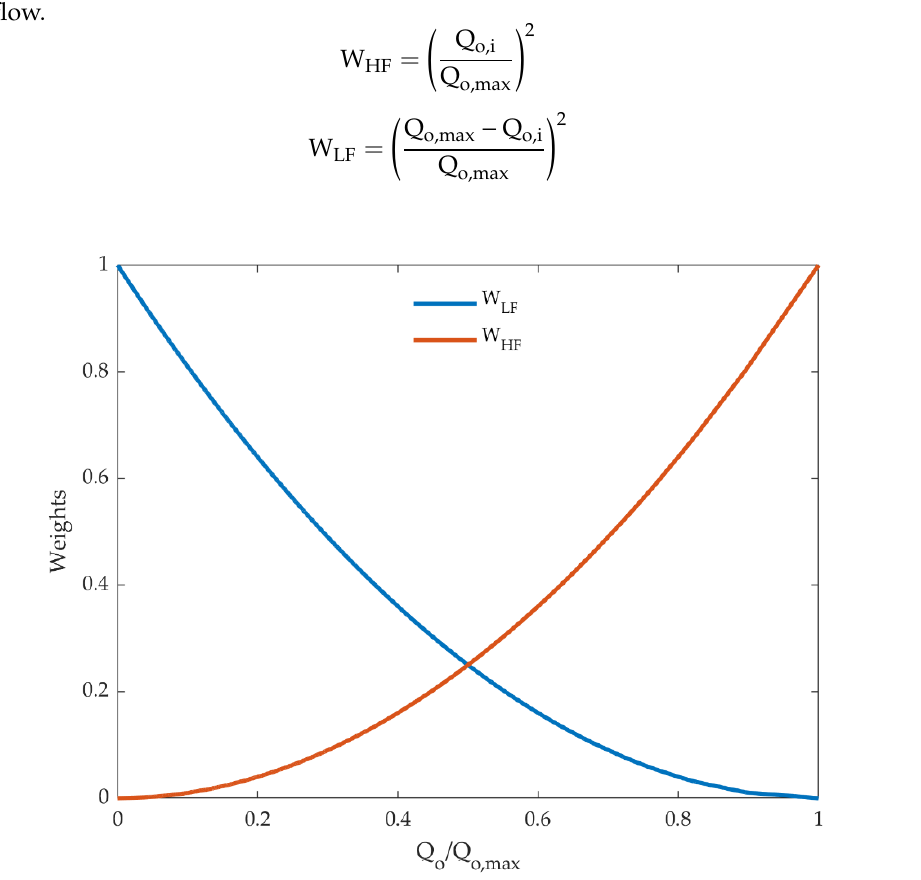
Figure 3. Weight functions for high and low flows. Reproduced with permission from Kayastha et al., Hydrology and Earth System Sciences; published by Copernicus Publications on behalf of the European Geoscience Union, 2012 [11].